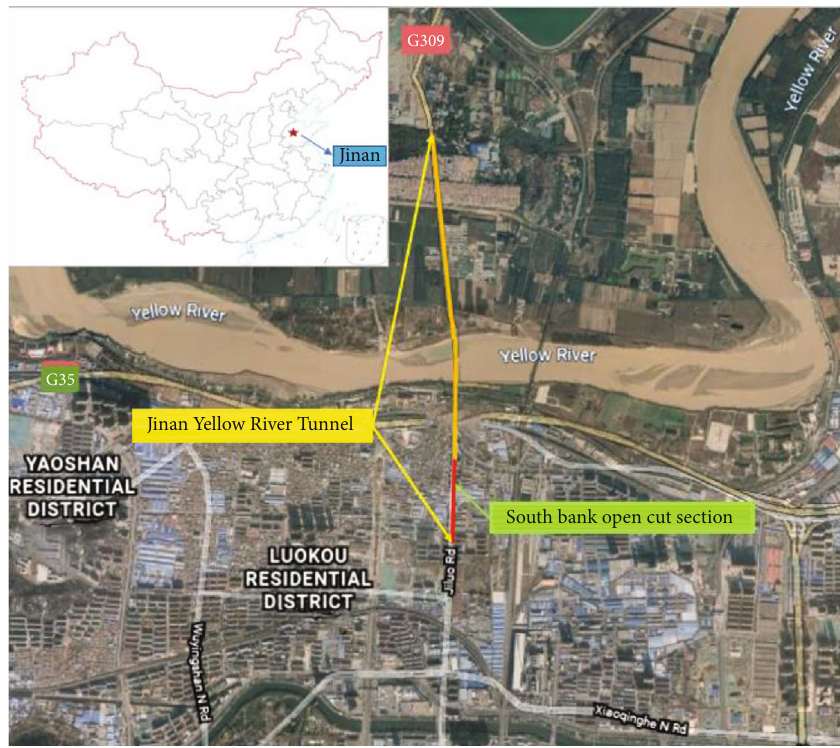
Figure 1: Map featuring the location of the fi eld